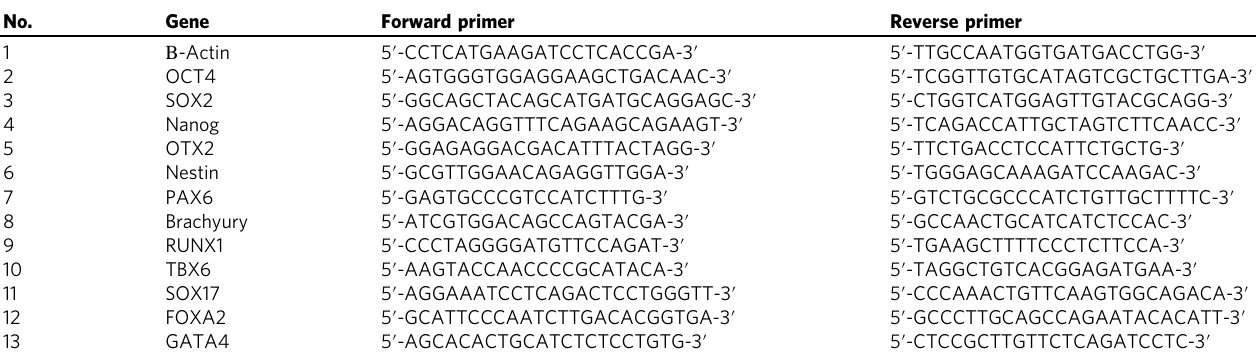
Table 2 The list of primers used in this